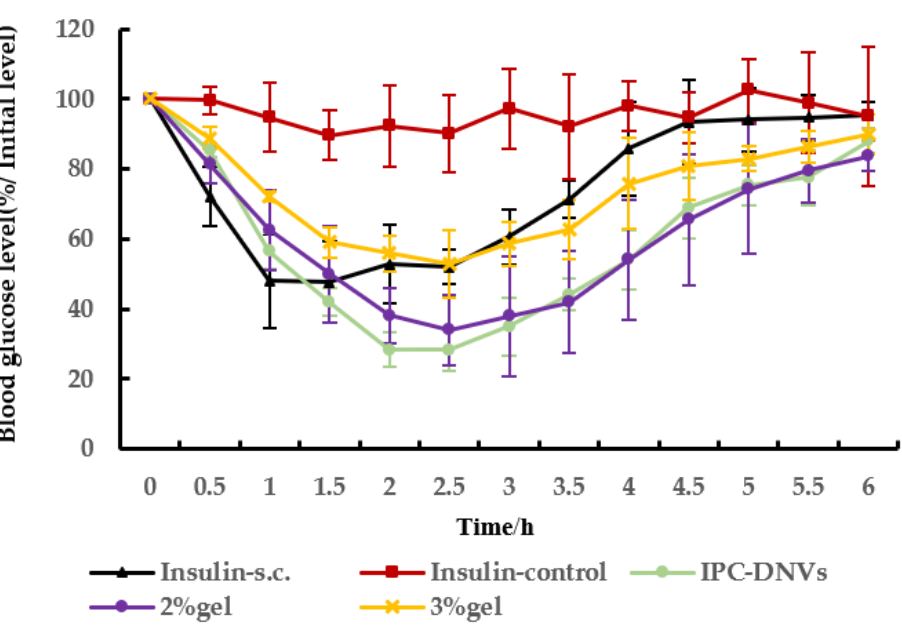
Figure 3. In vivo hypoglycemic effect of IPC-DNV gels with different gelatin content.